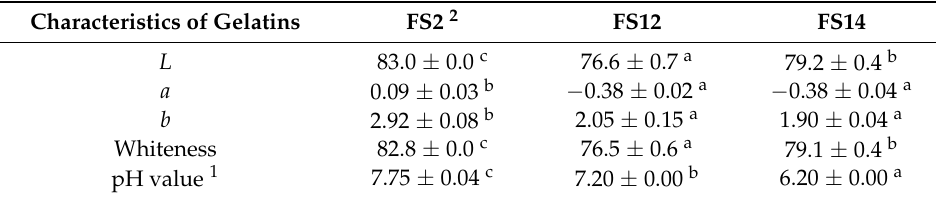
Table 1. Characteristics of gelatins FS2, FS12, and